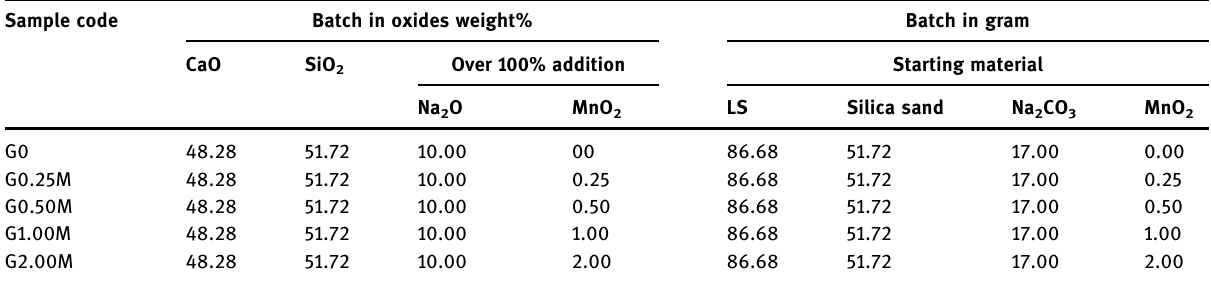
Table 1: Chemical composition of the glass batches Sample